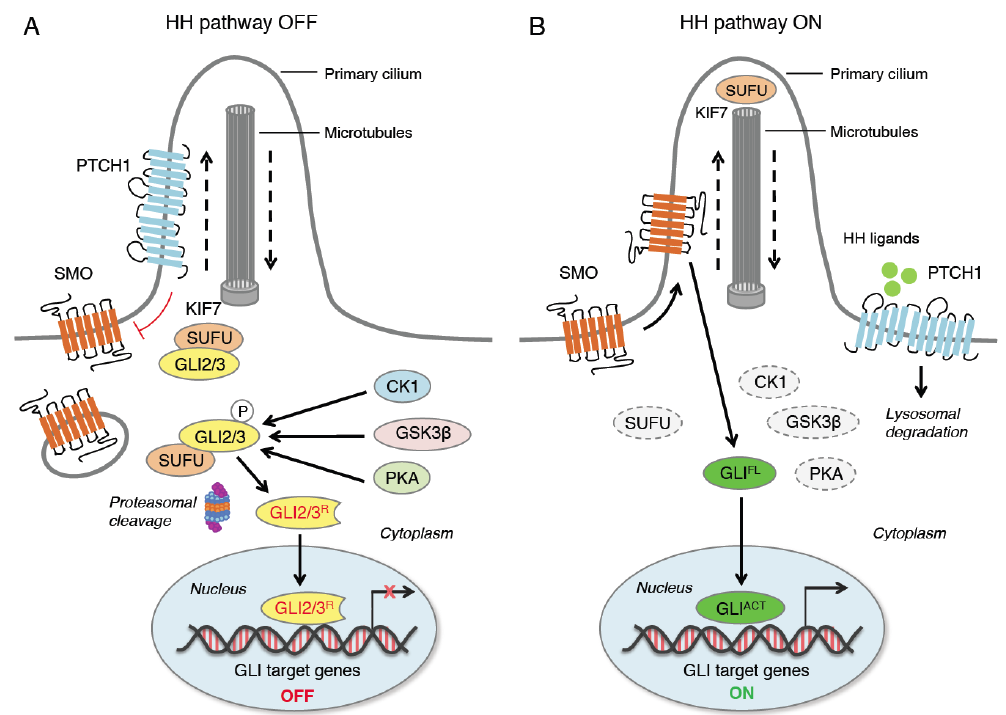
Figure 1. Canonical activation of HH signaling. When HH ligands are not present ( A ), PTCH1 represses SMO by preventing its entry into the primary cilium (PC). GLI2 and GLI3 are sequestered in the cytoplasm by SUFU and phosphorylated by PKA, CK1 and GSK3 β . The GLI undergo ubiquitination through the E3 ubiquitin ligase β -TrCP. GLI1 is fully degraded, whereas GLI3 and, to a lesser extent, GLI2 undergo partial proteasome degradation, leading to the formation of repressor forms (GLI3/2 R ) that move into the nucleus inhibiting the transcription of GLI target genes. In the presence of HH ligands ( B ), PTCH1 is displaced from the PC and undergoes lysosomal degradation, and SMO translocates into the PC. Active SMO relieves the SUFU-mediated suppression of GLI2 and GLI3, triggering a signaling cascade that leads to the translocation of full length activated forms of GLI (GLI ACT ) into the nucleus, where they promote the transcription of GLI target genes. KIF7 is a kinesin protein that acts in anterograde transport (from base to tip) of the PC. CK1, casein kinase 1; GLI2/3 R , GLI2/3 repressors; GLI ACT , GLI activators; GLI FL , GLI full length; GSK3 β , glycogen synthase kinase 3 β ; HH, Hedgehog; KIF7, kinesin family member 7; PKA, protein kinase A; PTCH1, Patched 1; SMO, Smoothened; SUFU, Suppressor of Fused; β -TrCP, β -transducin repeat-containing protein.